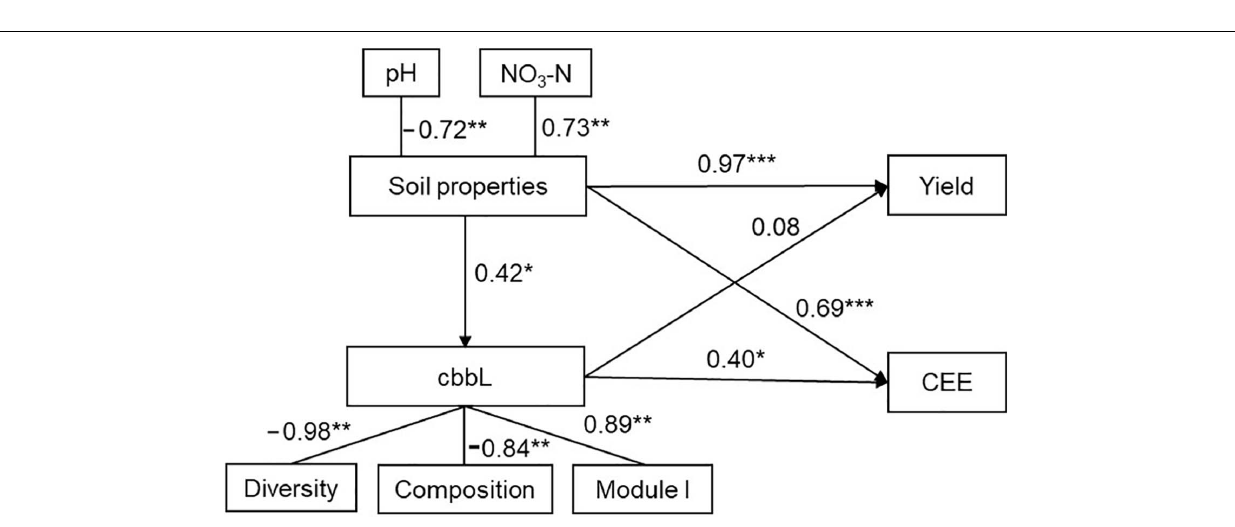
Frontiers in Microbiology |